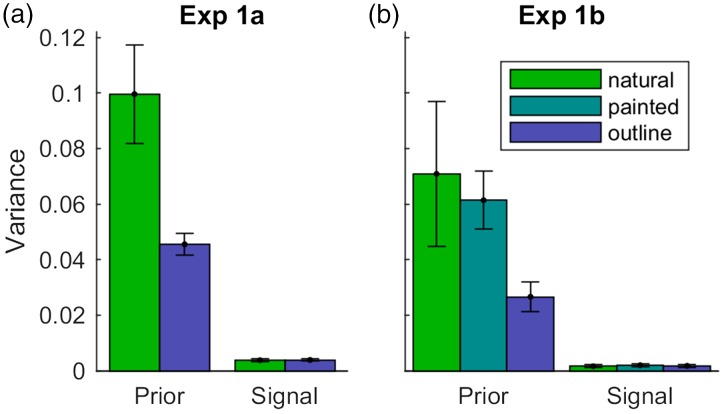
Comparison of variance in colour adjustments across conditions. (a and b) Experiments 1a and 1b of Olkkonen et al. (2008). The different bar colours refer to the different conditions, that is, those with photographs (green), with outline shapes (blue) and with painted fruits (green–blue). The y-axis represents the variance of adjustments for the prior (typical adjustments) and the signal (grey adjustments) averaged across observers and stimuli. To give an idea of variation, error bars indicate standard errors of mean across the eight stimuli. The variances inform about the reliability of adjustments. Note that variance for typical adjustments was higher (i.e., lower reliability) for photographs of natural and painted fruits than for uniformly coloured outline shapes.